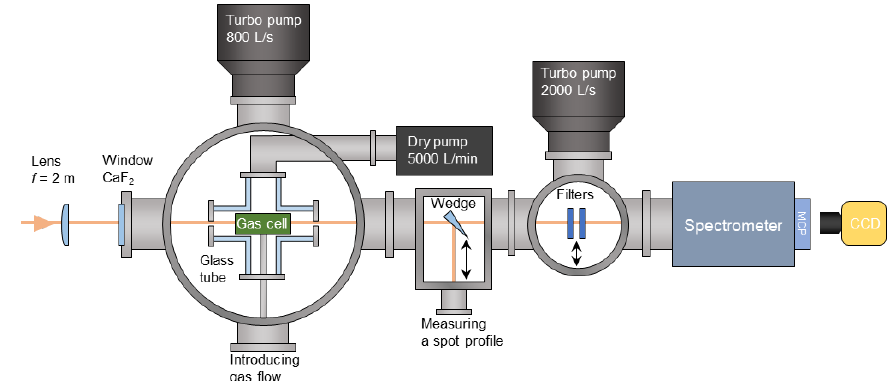
Fig. 1. Experimental setup for HHG driven by loosely focused infrared pulses.